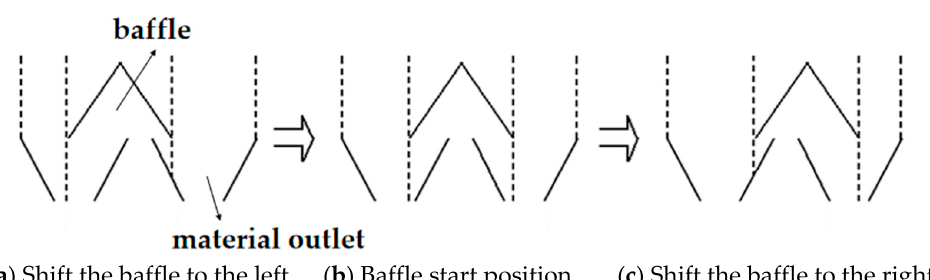
Figure 9. Schematic diagram of position change of tea baffle. ( a ) is the baffle moving 1 cm to the left, ( b ) is the initial position, and ( c ) is the baffle moving 1 cm to the right.